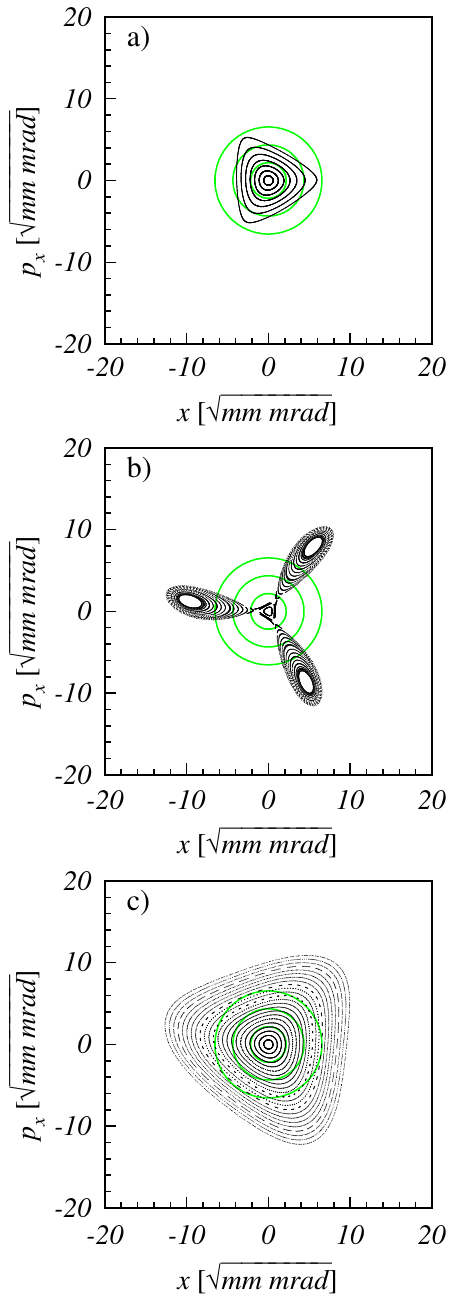
FIG. 7. Phase space portrait of the stable orbits for (a) Q x ¼ 4 : 328 , (b) Q x ¼ 4 : 334 , and (c) Q x ¼ 4 : 34 . The dy- namics is determined only by the magnet nonlinearities. No space charge is